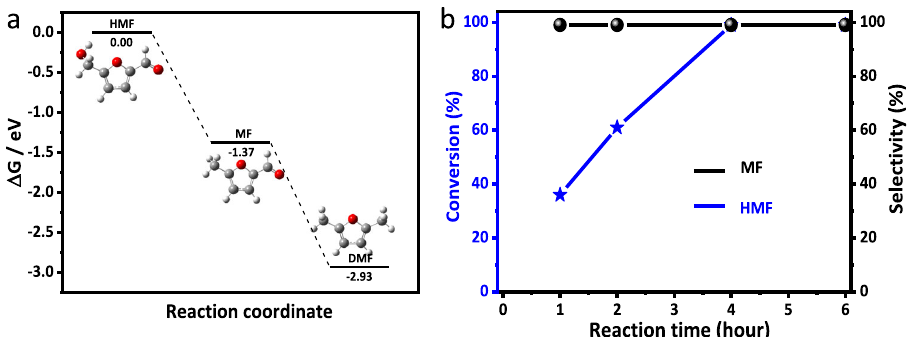
Fig. 4 Factors affected the selective hydrogenation of HMF to MF. a Gibbs free energy of HMF hydrogenation to MF and DMF from DFT calculation. C, H, and O atoms are represented as silver, white, and red balls. b The effect of reaction time over Pt 1 /Nb 2 O